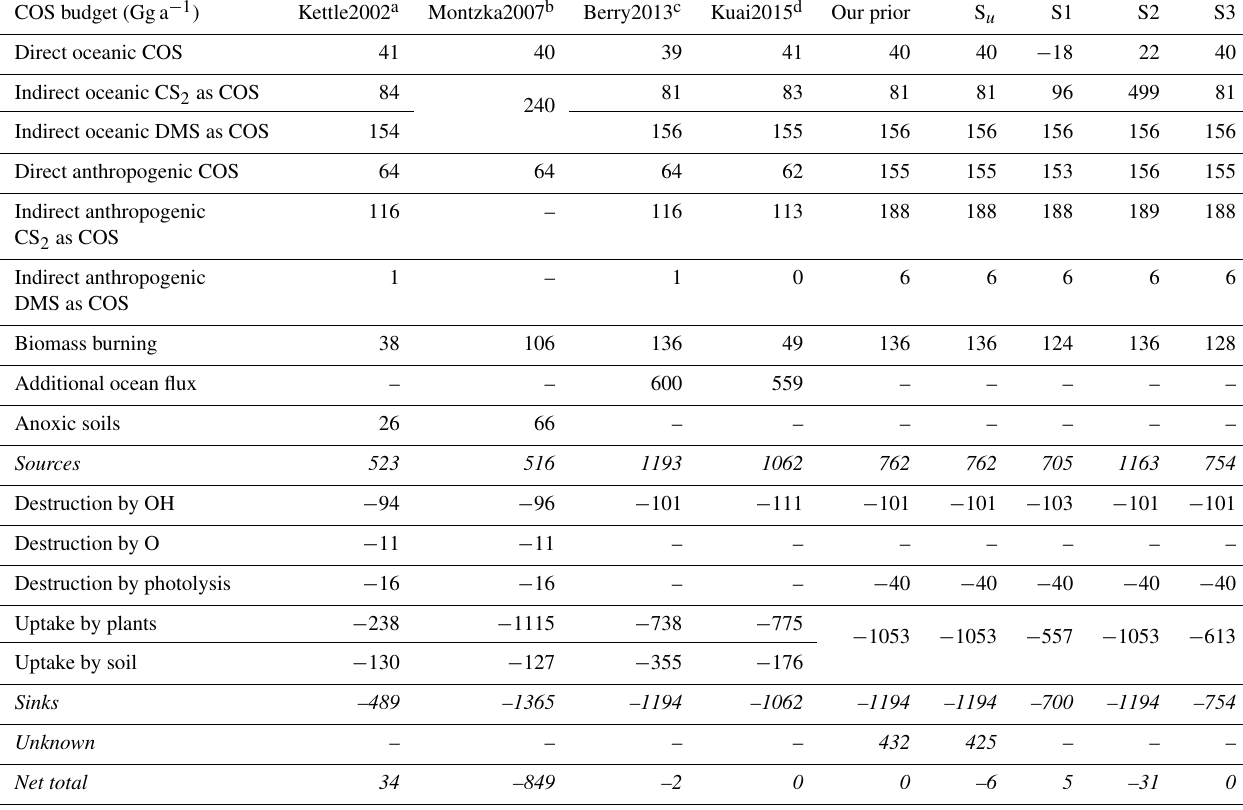
Table 4. Results from inversions S u , S1, S2 and S3 compared to published global COS budgets. The total sources, total sinks, the unknown flux and the total flux are shown in